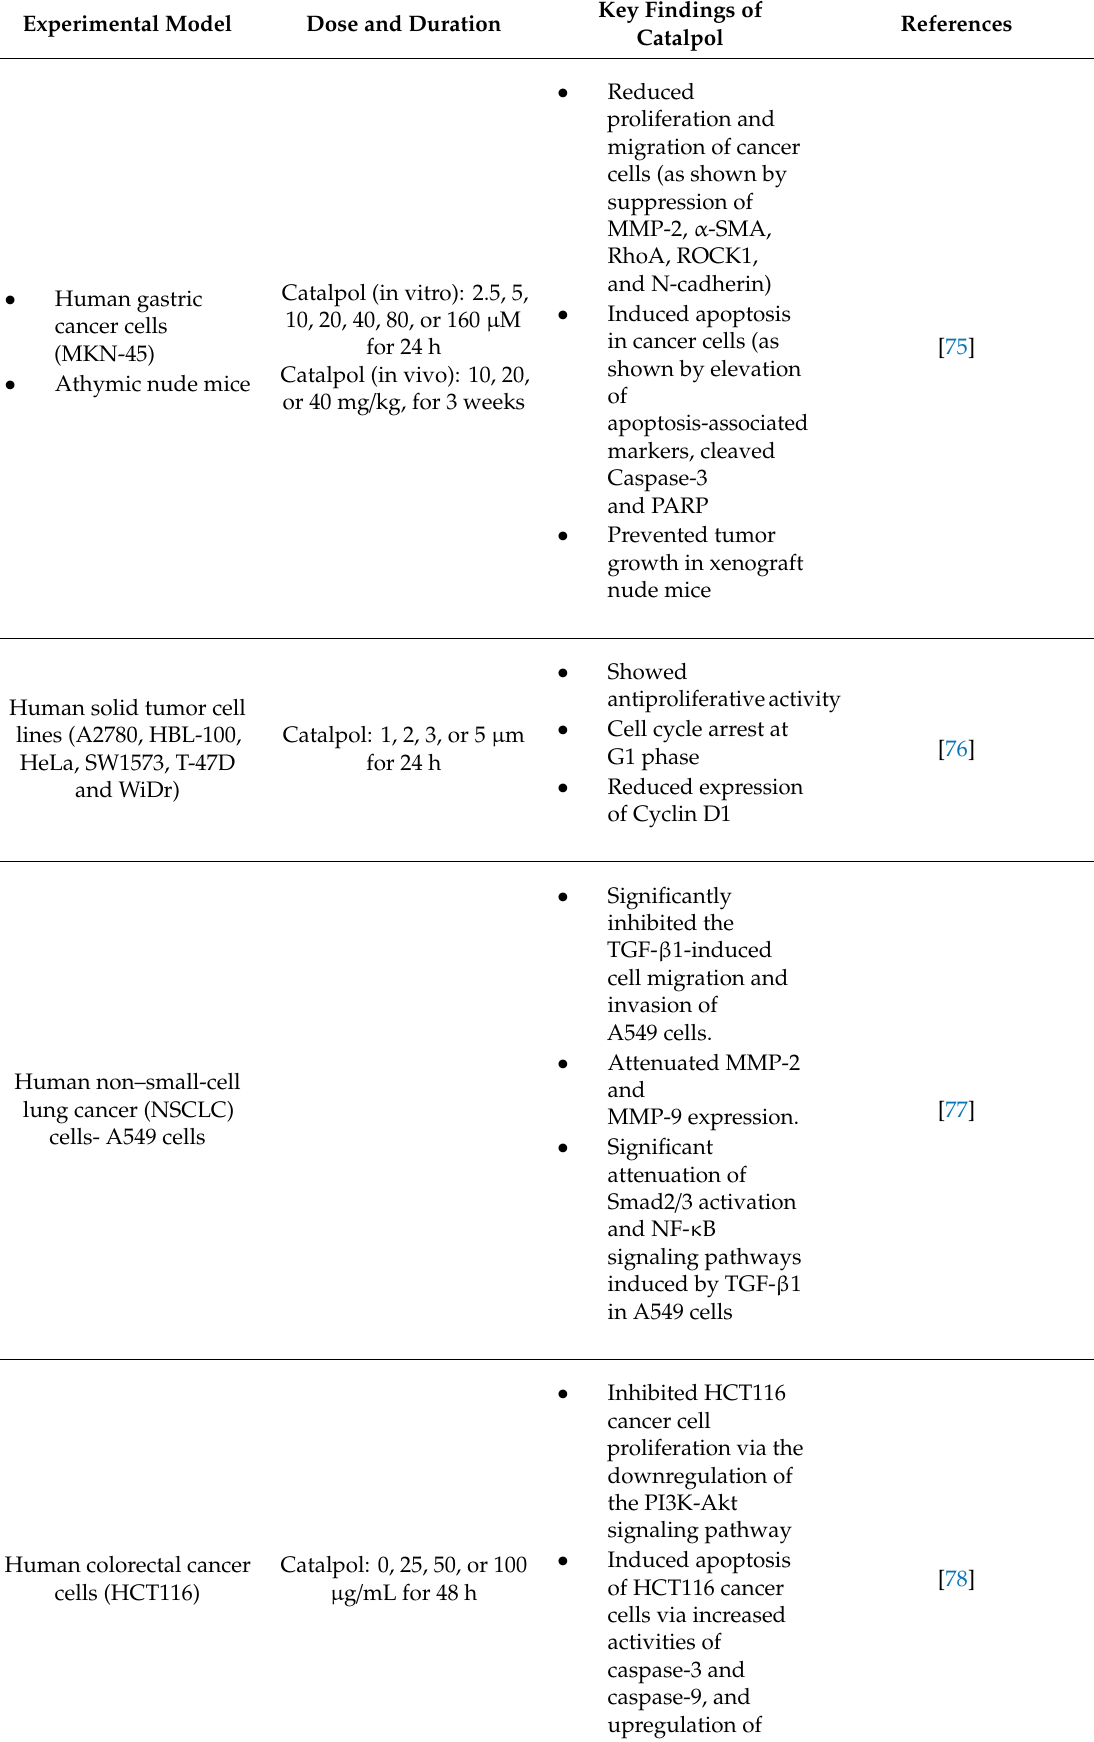
Table 5. E ff ect of catalpol in experimental models of